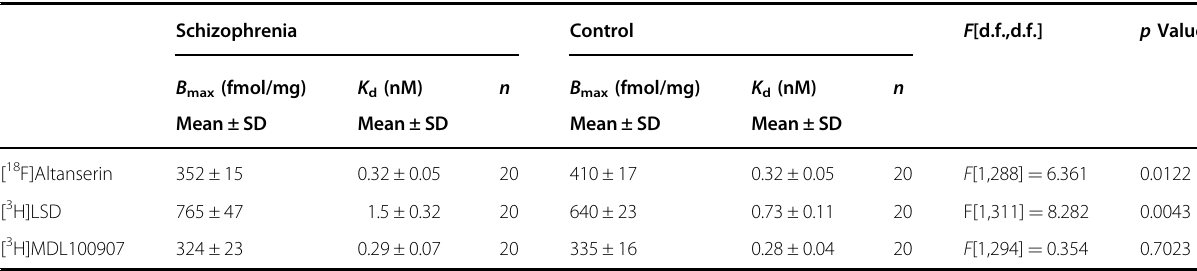
Table 1 Radioligand binding parameters in the prefrontal cortex of subjects with schizophrenia and matched